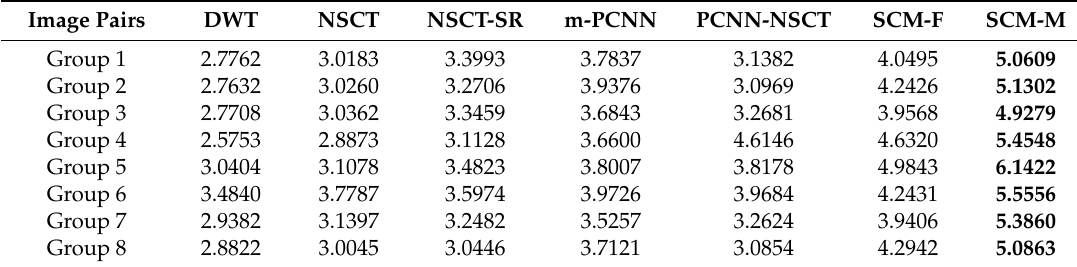
Table 1. Q M for the seven methods operating on the eight groups of medical images.